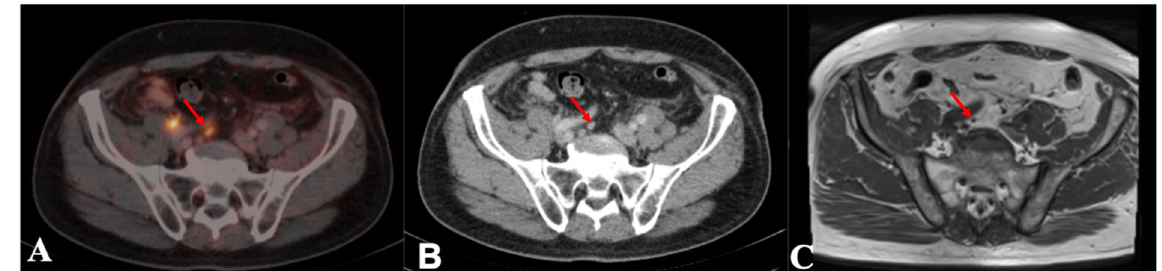
Figure 6. Example of a lymph node smaller than 10 mm in 68 Gallium-Prostate specific membrane antigen PET-CT compared to T1 MRI. This figure shows a suspicious lymph node smaller than 10 mm diameter. The lymph node is visualized in corresponding axial plane slices using CT, 68 Gallium-Prostate specific membrane antigen PET-CT and T1 MRI from left to right. The suspected lymph node is located at the right common iliac artery and is challenging to detect in T1 MRI. The lymph node is highlighted through red arrows. ( A ) Lymph node depicted in CT, ( B ) Lymph node depicted in 68 Gallium-Prostate specific membrane antigen PET-CT, ( C ) Lymph node depicted in the T1 sequence in